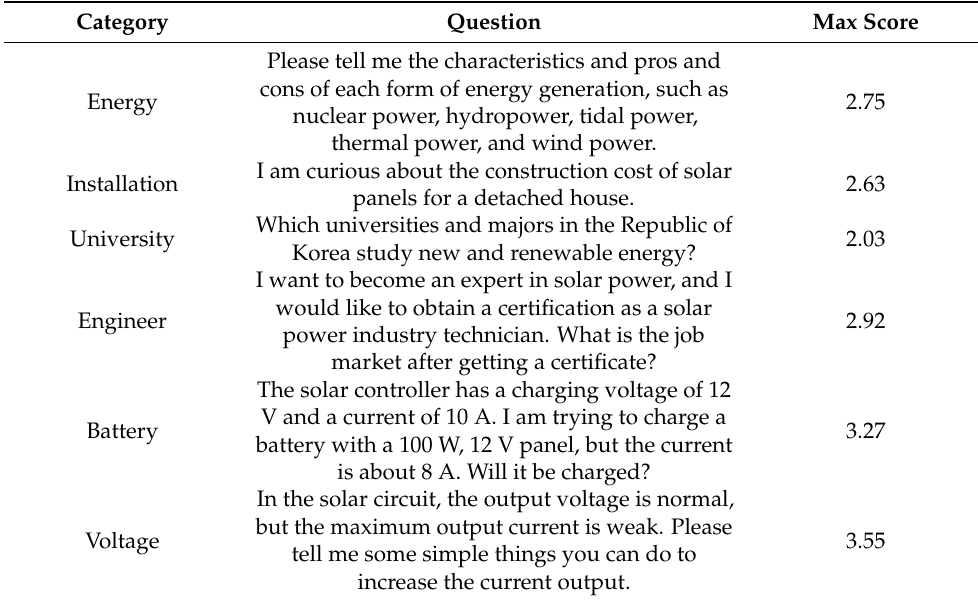
Table 8. List of questions with the highest score for each